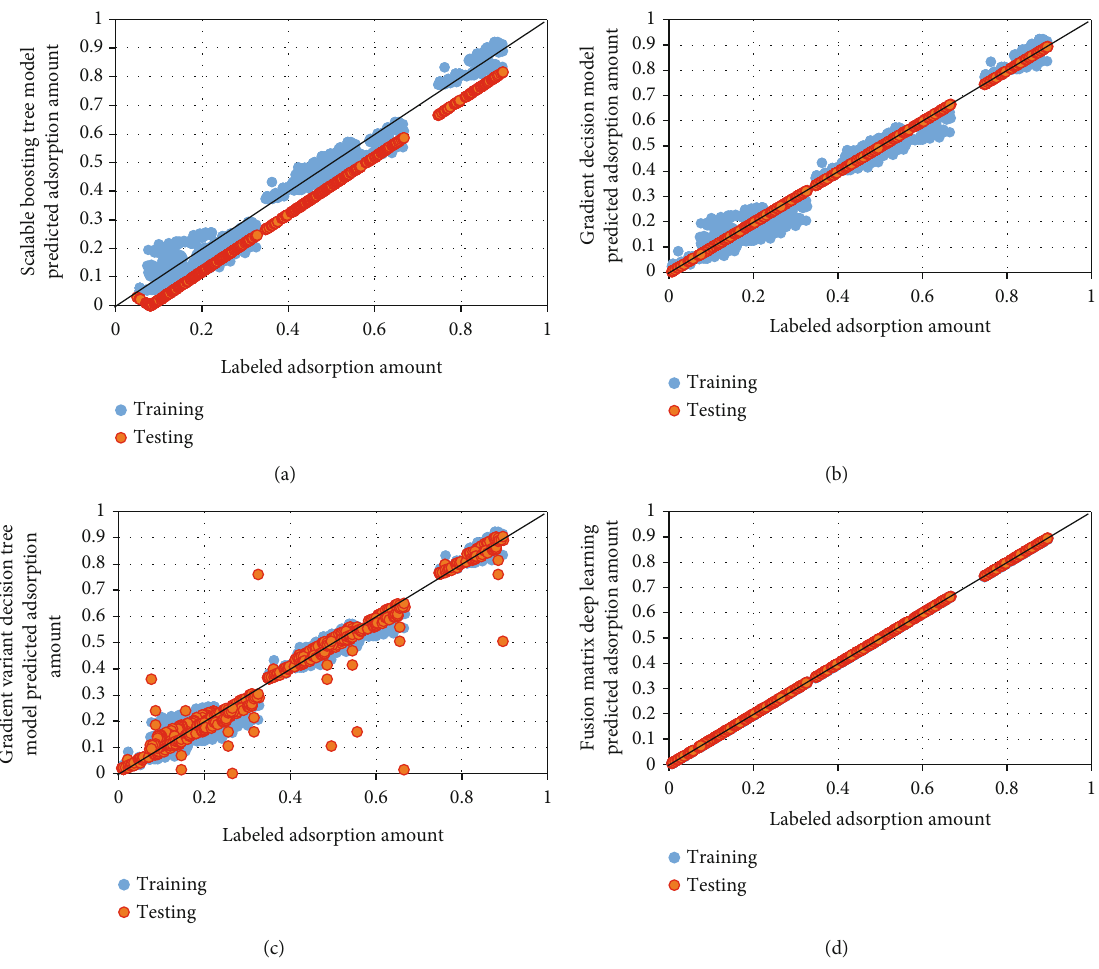
Figure 9: Prediction using scalable boosting tree model (a), gradient decision model (b), gradient variant decision tree model (c), and our proposed model Fusion matrix deep learning model (d). The red color represents 96% con fi dence of the regression for the test items. The black line is the equality line ( y = x ). The prediction accuracy of the models followed comparable trends but with di ff used accuracy.